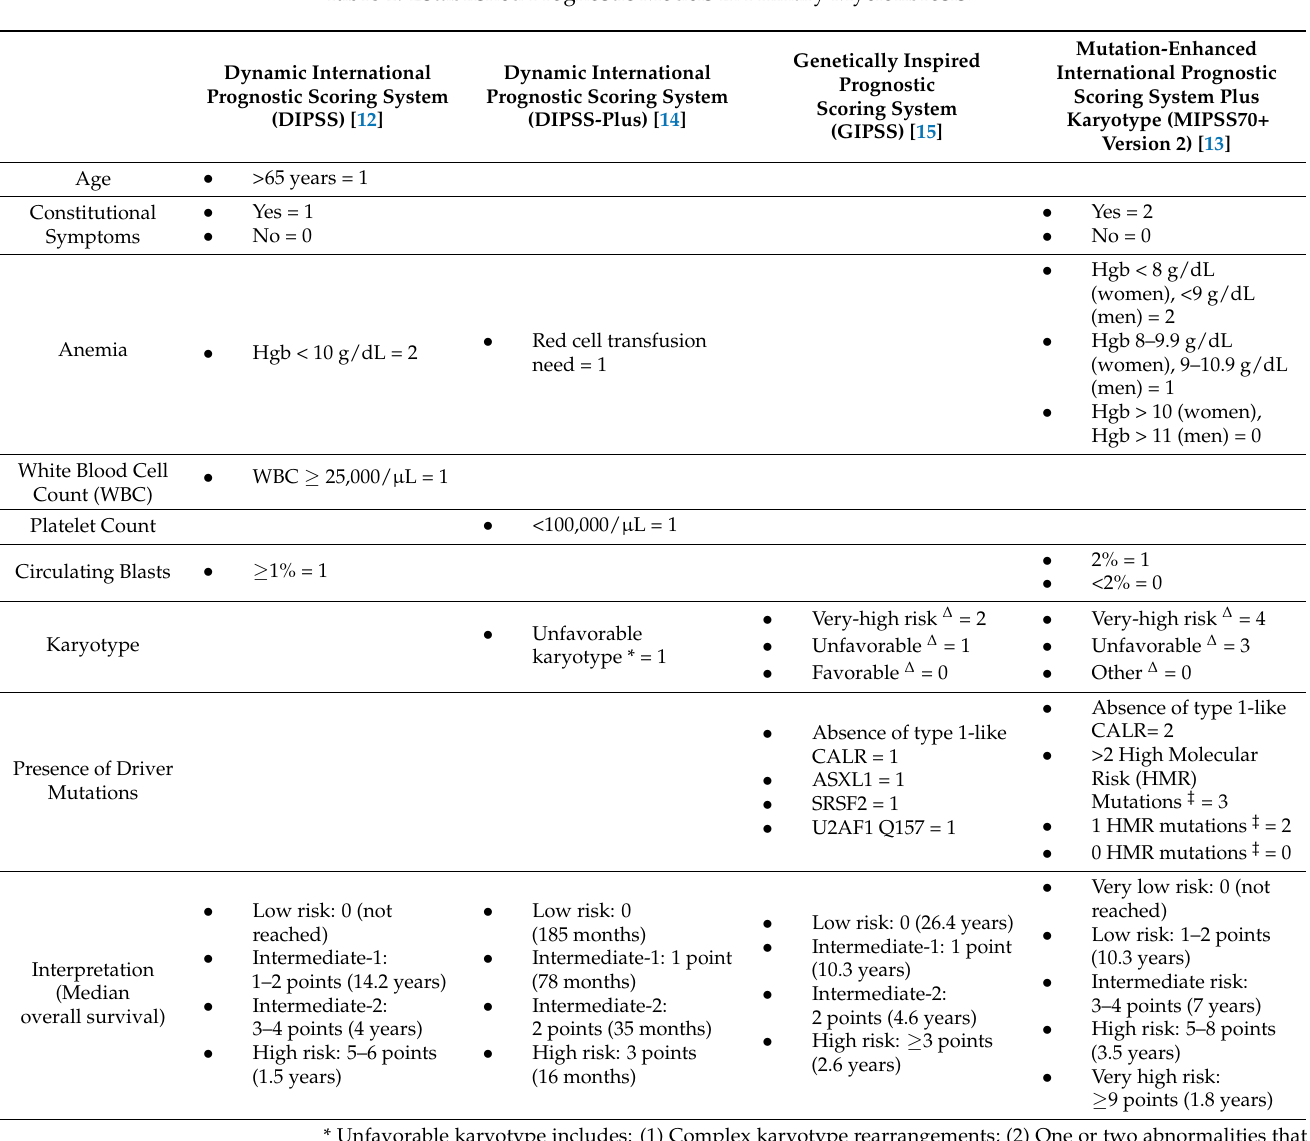
Table 1. Established Prognostic Models in Primary Myelofibrosis.